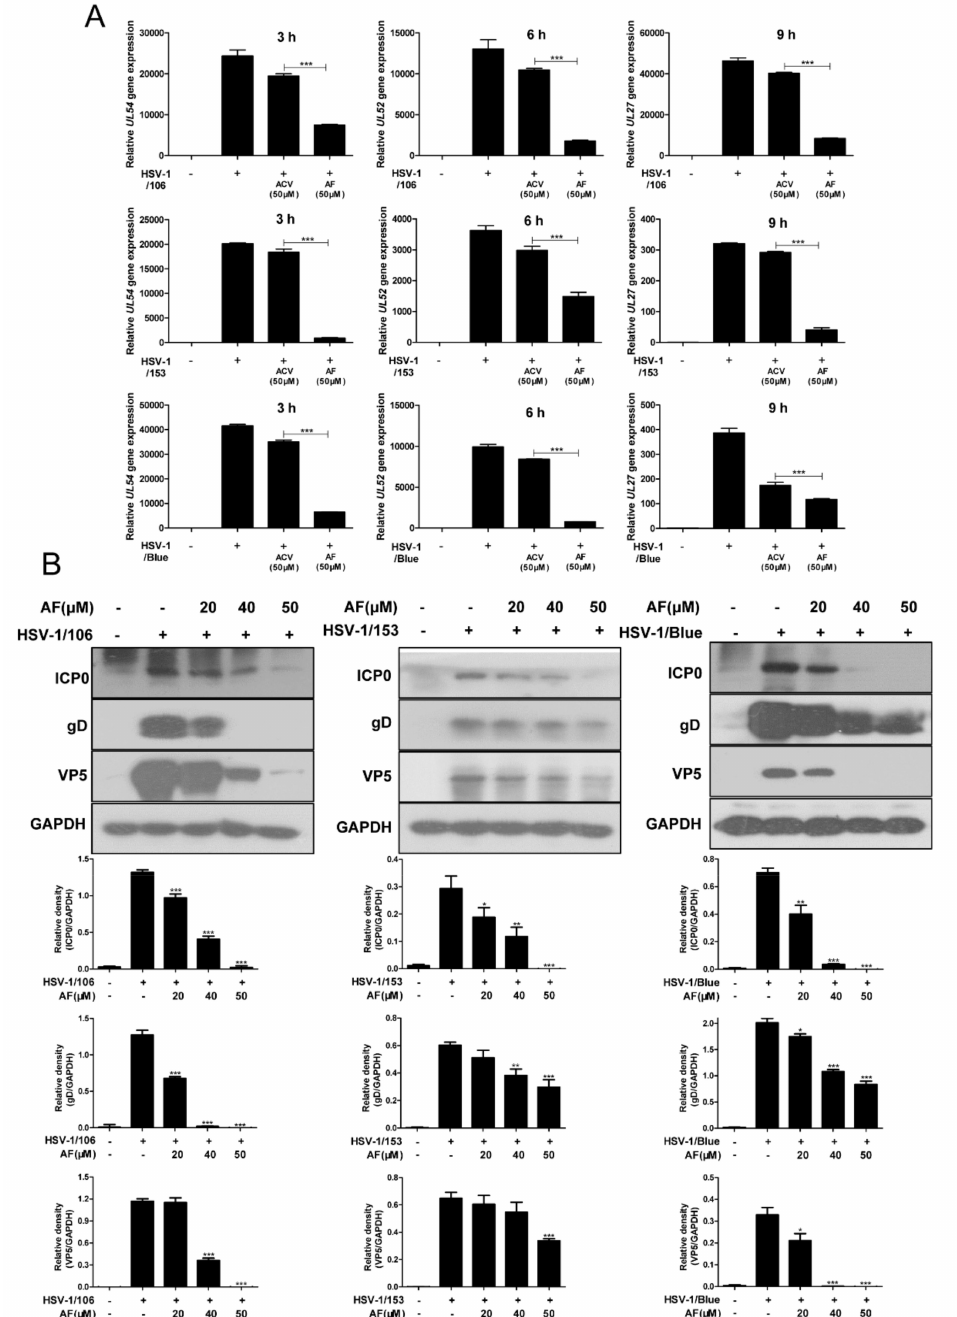
Figure 4. Amentoflavone a ff ects the gene and protein expression of ACV-resistant viruses. ( A ) Vero cells were infected with HSV-1 / 106, HSV-1 / 153, and HSV-1 / Blue (MOI = 1) in the presence of ACV (50 µ M), amentoflavone (50 µ M), or DMSO (control group). Total RNA samples were extracted to detect the expression levels of UL54 , UL52 , and UL27 at 3, 6, and 9 h p.i., respectively. Data are mean ± SD ( n = 3). *** p < 0.001. ( B ) The expression of various viral proteins was detected by Western Blot. The cells infected with HSV-1 were treated with amentoflavone or DMSO (control group) for 3 h and total proteins were subjected to western blot for ICP0 analysis. For viral late protein gD and VP5, the cells were infected with HSV-1 for 9 h in the presence of amentoflavone or DMSO. Di ff erent protein concentrations for the di ff erent virus samples were used for Western blot. Data are mean ± SD ( n = 3). * p < 0.05; ** p < 0.01; *** p < 0.001 versus HSV-1-treated